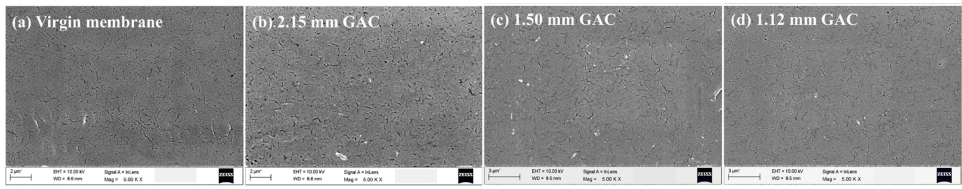
Figure 7. SEM images of ( a ) a virgin membrane and cleaned membranes from GAC-PAC-UF system with GAC particle diameters of ( b ) 2.15 mm, ( c ) 1.50 mm, and ( d ) 1.12 mm [25]. with GAC particle diameters of ( b ) 2.15 mm, ( c ) 1.50 mm, and ( d ) 1.12 mm